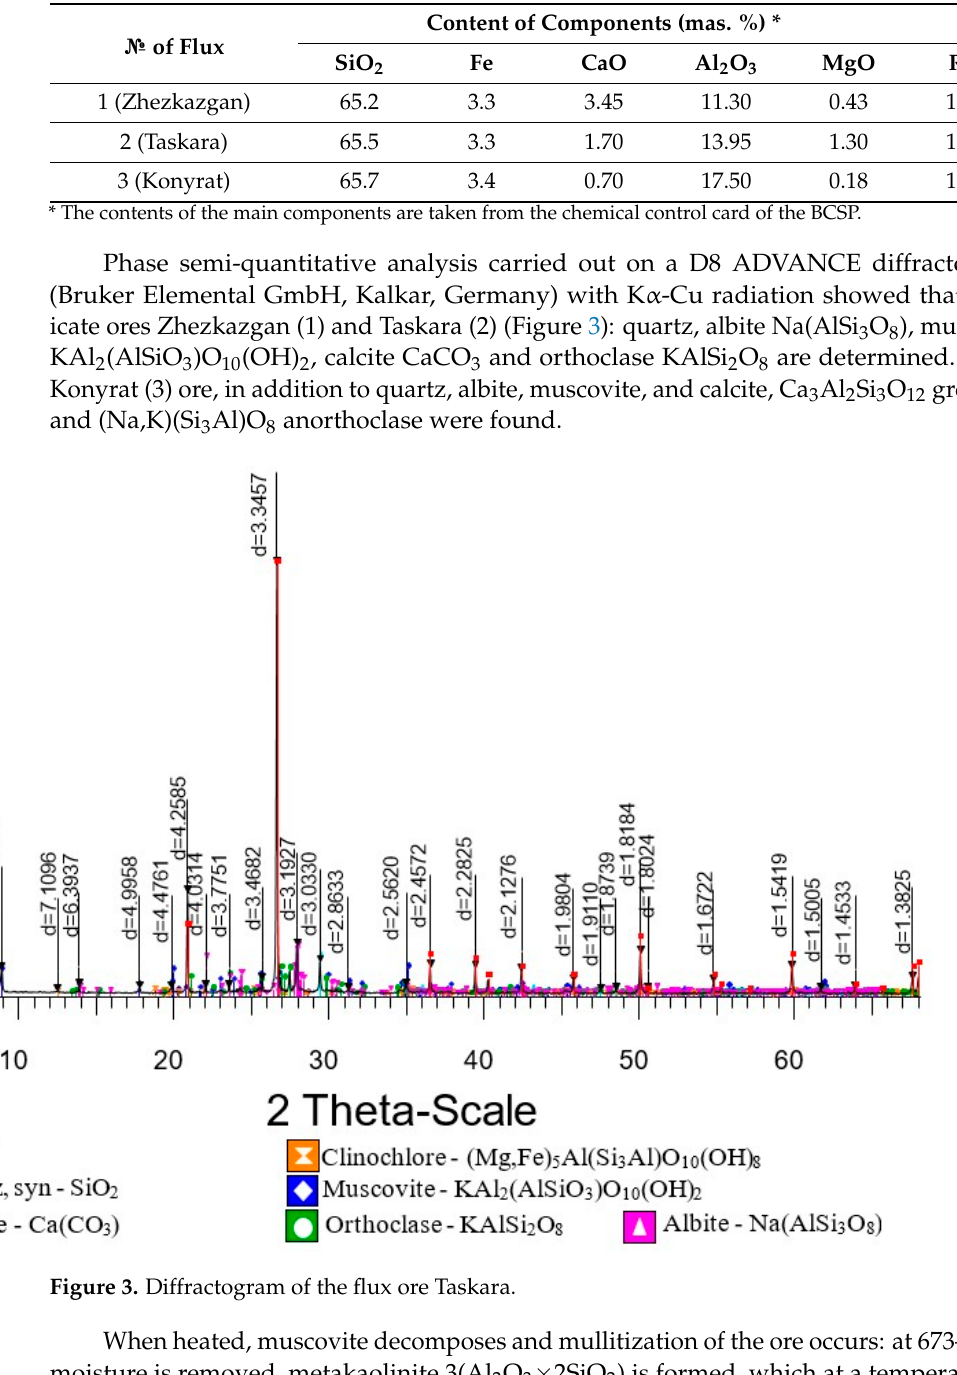
Table 1. Composition of flux ores used in copper plant (mas. %).